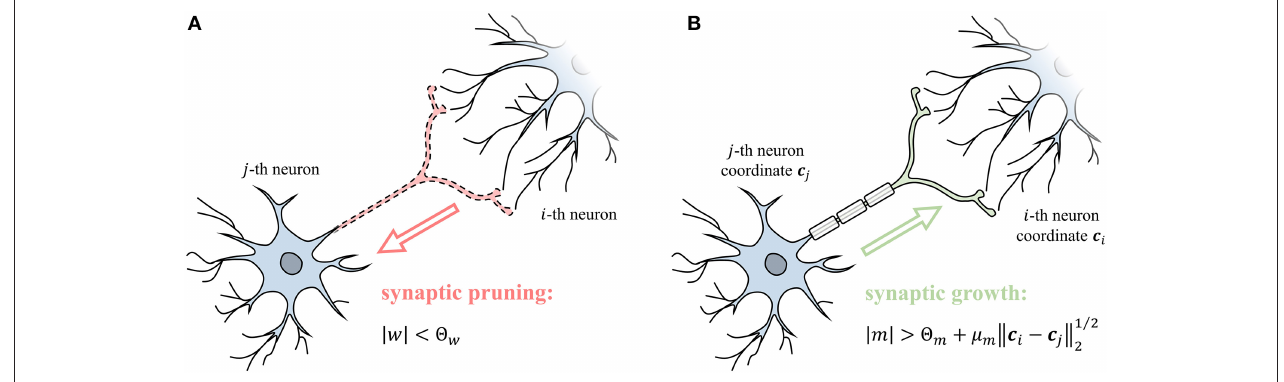
FIGURE 4 | (A) The weight of synapse w controls the synaptic pruning. (B) The momentum of the synapse gradient m controls the synaptic